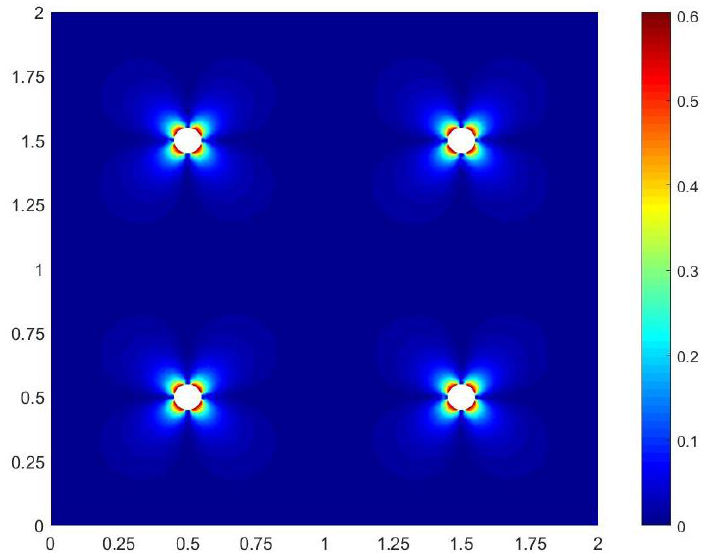
Figure 3. Color online. Model distribution of director on photosensitive surface. Parameters: r = 0.05, L = 1. The color bar indicates the range of azimuthal angle.